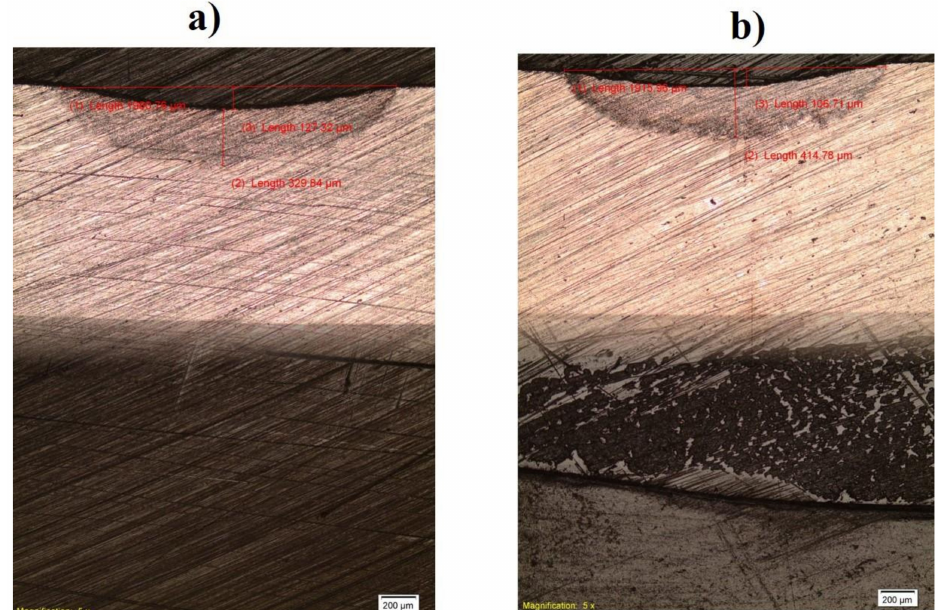
Figure 2. The macrographs of the experimental specimens ( a ) in air and ( b ) in serum.